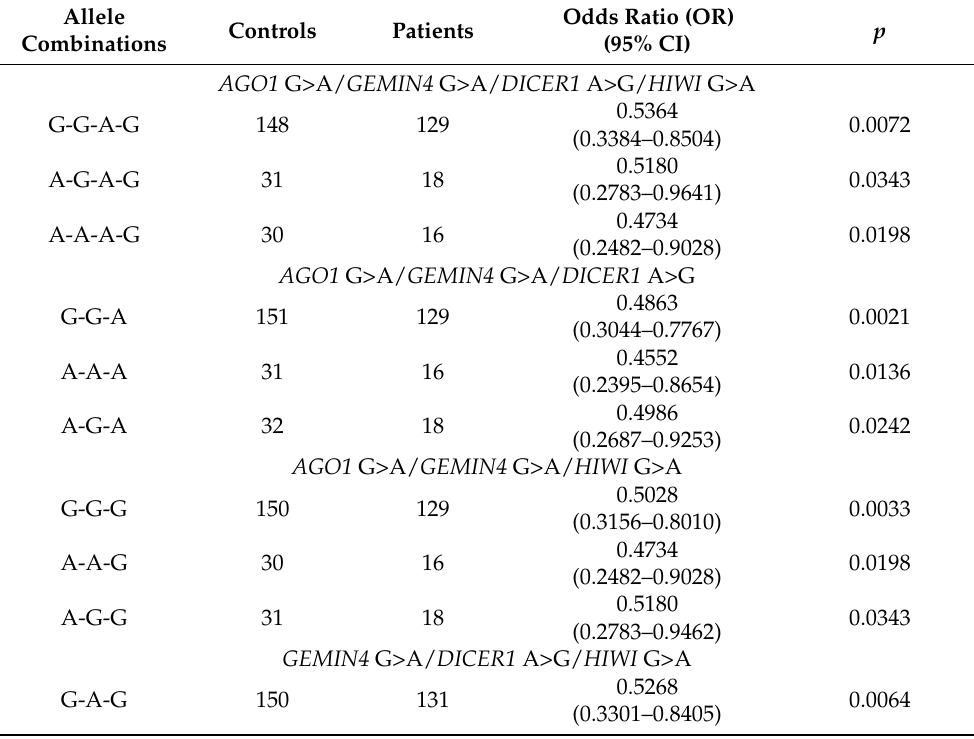
Table 4. Analysis of the synergistic effect of a combination of genetic variants of the rs636832, rs7813, rs3742330 and rs1106042 polymorphisms on the risk of developing